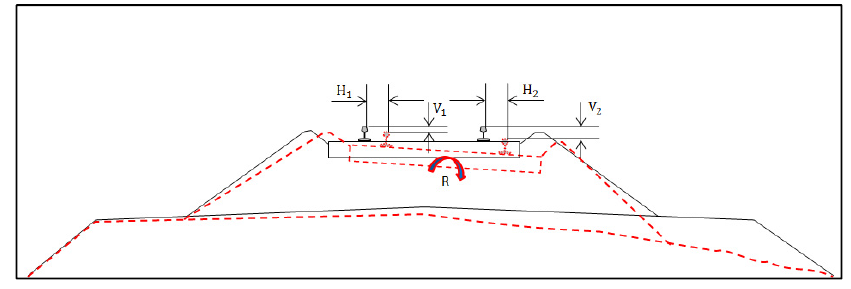
Figure 3 . Track movement on an unstable embankment—adapted from [17].